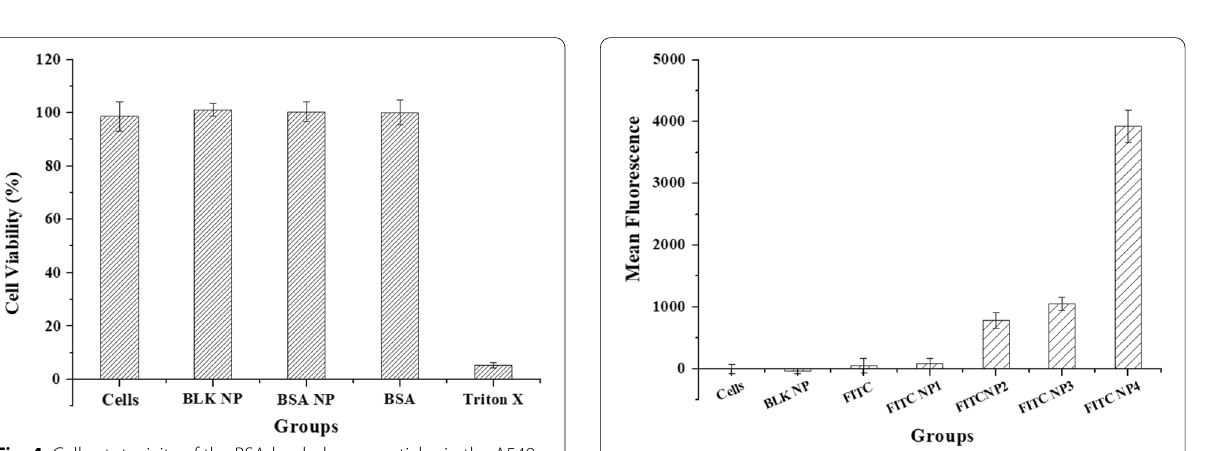
Fig. 5 Uptake study of FITC-loaded nanoparticles by the A549 cells (n 3), where NP1, NP2, NP3 and NP4 are 25 µl, 50 µl, 100 µl and = 150 µl of